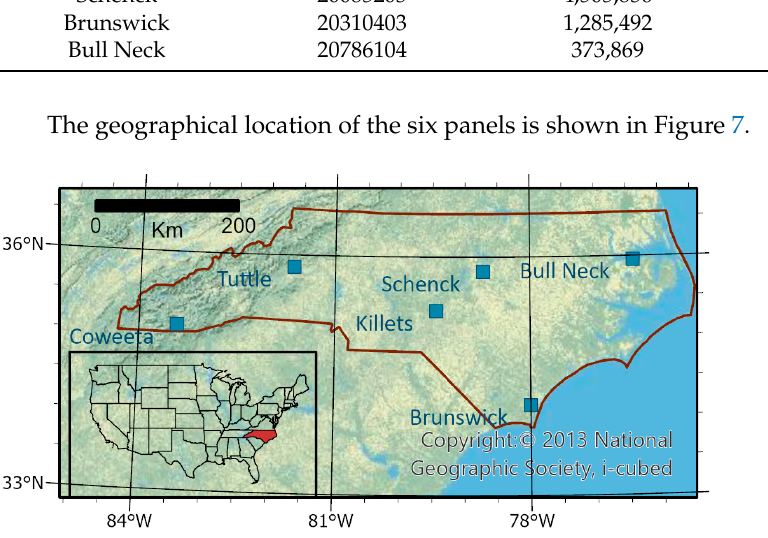
Figure 7. The locations of the six North Carolina Lidar panels used in the study with inset map showing the location of North Carolina within the United States. The blue blocks are not to scale. Actual panel sizes are provided in Table 4.